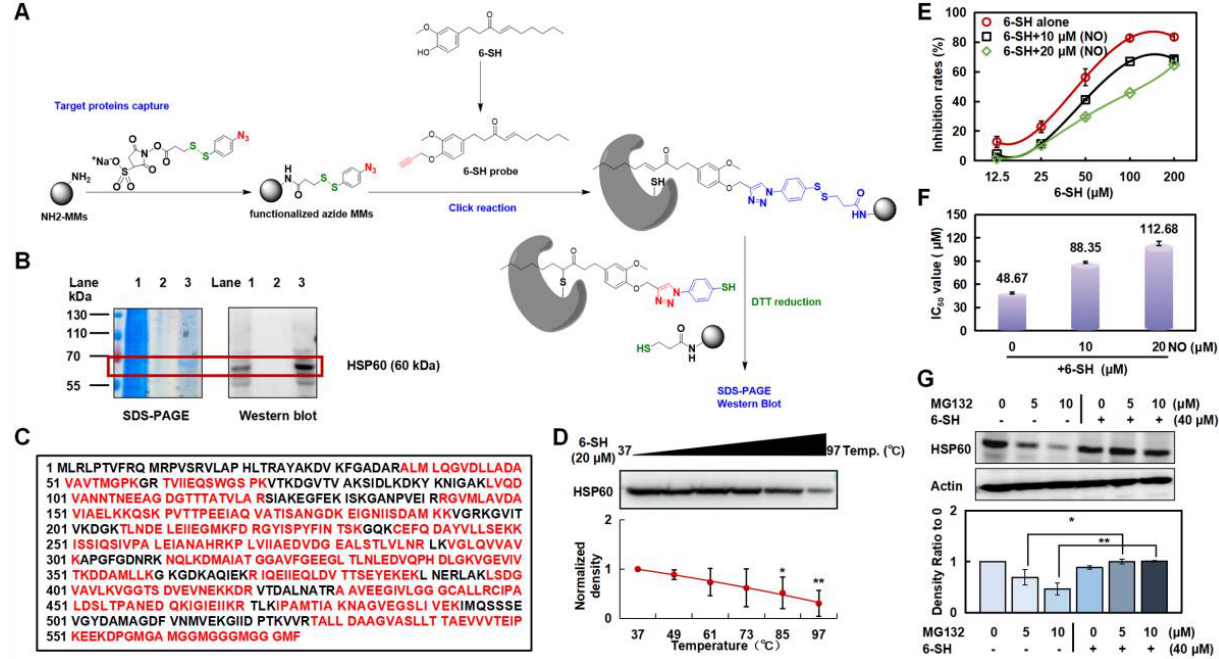
Figure 4. 6-SH targeted HSP60 and inhibited its stability. ( A ) The modification process of AL-6-SH- MMs and the technology roadmap for target fishing method. ( B ) SDS-PAGE and Western blotting analysis of captured protein by 6-SH probe (Lane 1: A549 lysate; Lane 2: a negative control without the 6-SH probe; Lane 3: 6-SH probe-captured proteins). ( C ) The sequence of HSP60 protein and the identified peptide (red). ( D , E ) 6-SH treatment (20 µM) inhibited the thermal stability of HSP60 measured by CETSA; the statistics show the normalized density ( n = 3). Values represent the means ± SD. * p < 0.05, ** p < 0.01 versus “Ctrl” group. ( E , F ) Cells were pre-treated with nonactin (10 or 20 μM) for 4 h, and then, they were treated with 6-SH for 72 h. The inhibition and IC 50 value of 6-SH were assayed. ( G ) A549 cells were treated with MG-132 (5 or 10 μM ) for 1h before the addition of 40 μM 6-SH for another 5 h, and then, the HSP60 was examined; the statistics show the normalized density ( n = 3). Values represent the means ± SD. * p < 0.05, ** p < 0.01 versus corresponding group.